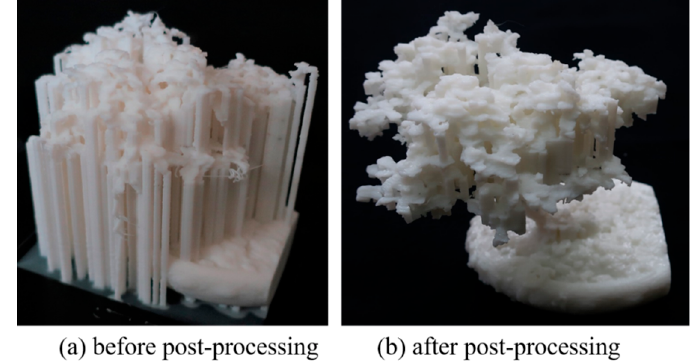
Figure 12. Printed results of the bonsai model, ( a ) before removing support structures and ( b ) after the postprocessing.